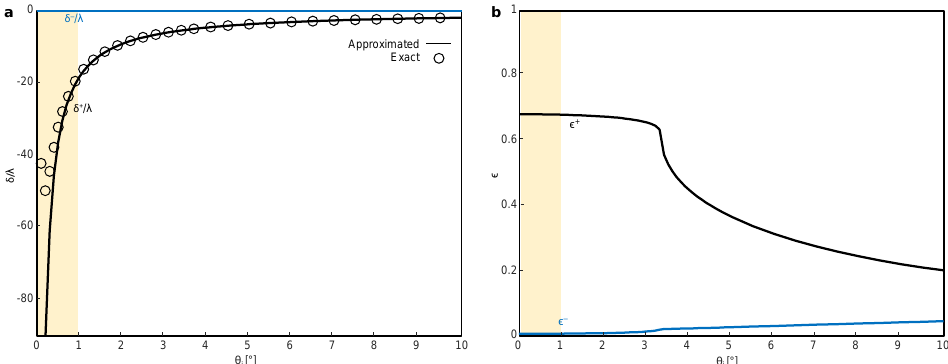
Figure 4. SHEL and its efficiency at the metasurface under LCP incidence. Shaded areas indicate the region in which the large beam waist condition ( k 2 RCP (blue) reflected beams. Solid curves and markers indicate results calculated with and without the large beam waist assumption. ( b ) (cid:101) of the LCP (black) and RCP (blue) reflected